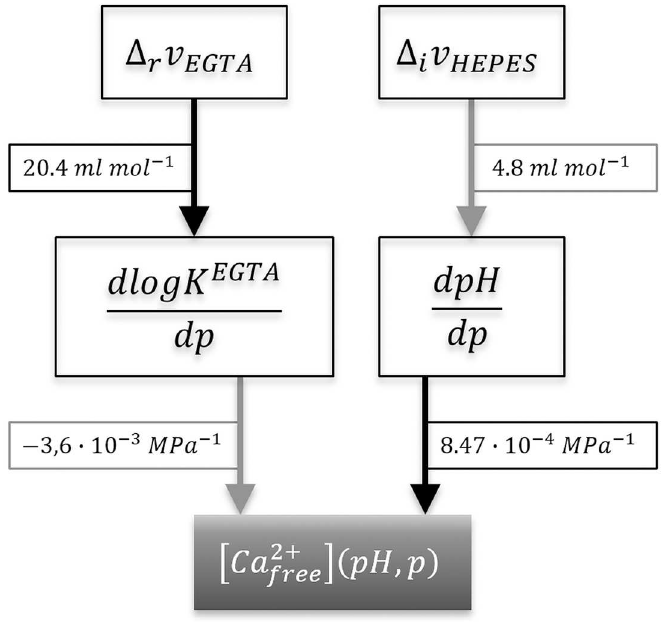
(cid:138) . A positive influenceon the free